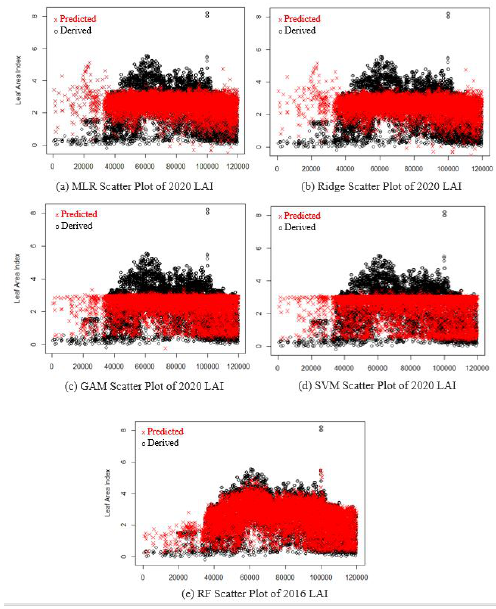
Figure 6. Derived and predicted LAI for each model in 2020.